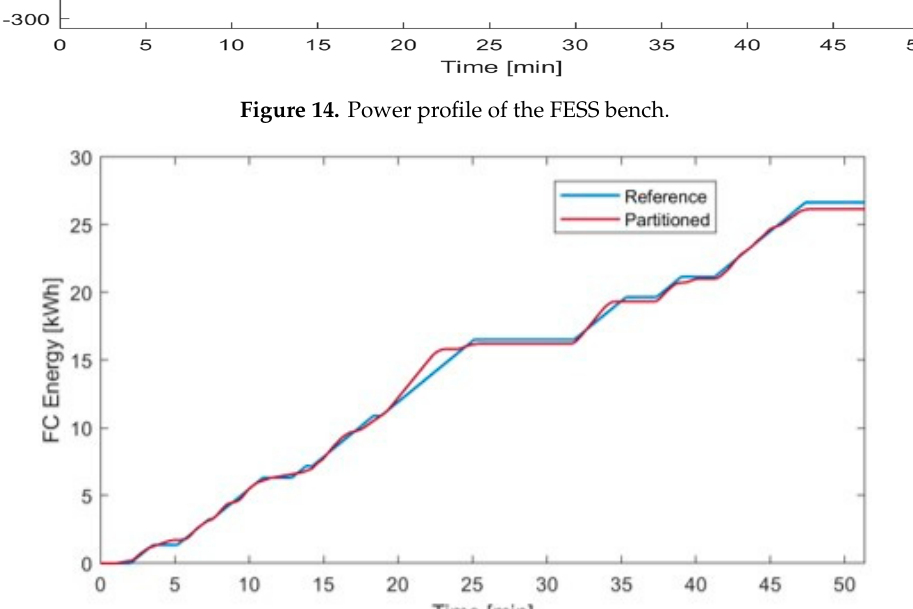
Figure 15. FC output energy: Comparison between FC partitioned in three stacks, and benchmark single stack case.